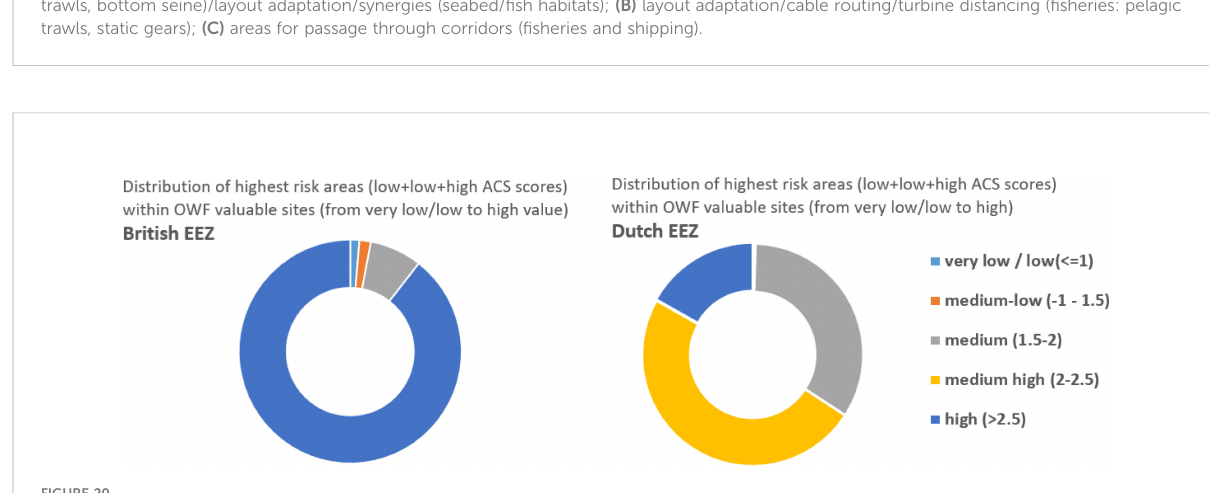
FIGURE 19 Spatial localization of priority areas (within high value OWF sites) where speci fi c con fl ict resolution strategies can be relevant (based on level of con fl ict-ACS values and management strategies for the overlapping sea user types): (A) compensation ( fi sheries: beam trawls, bottom otter trawls, bottom seine)/layout adaptation/synergies (seabed/ fi sh habitats); (B) layout adaptation/cable routing/turbine distancing ( fi sheries: pelagic trawls, static gears); (C) areas for passage through corridors ( fi sheries and